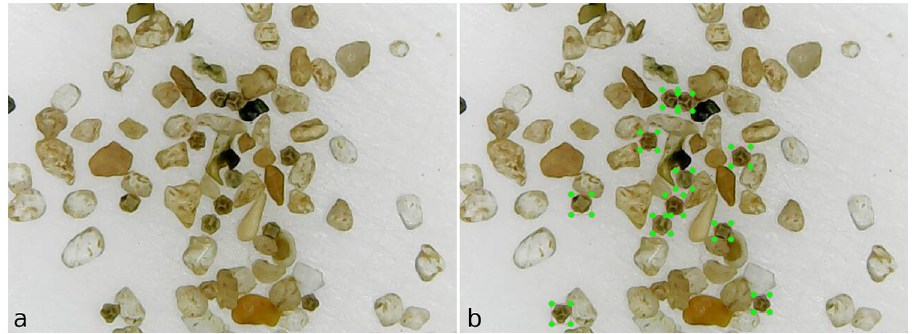
Fig 3. The labeling process using the LabelImg software: a) Sample of substrate image captured by the XTRAD USB digital microscope model XT-2036 at a 52x magnification; b) Using the LabelImg software to label samples of cysts. The green rectangles in the image are the labeled cysts.